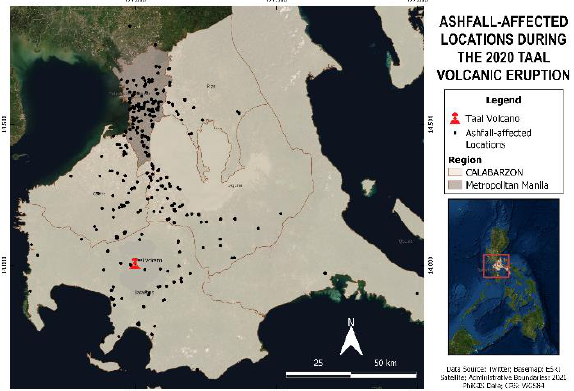
Figure 3. Dot density map of ashfall-affected locations